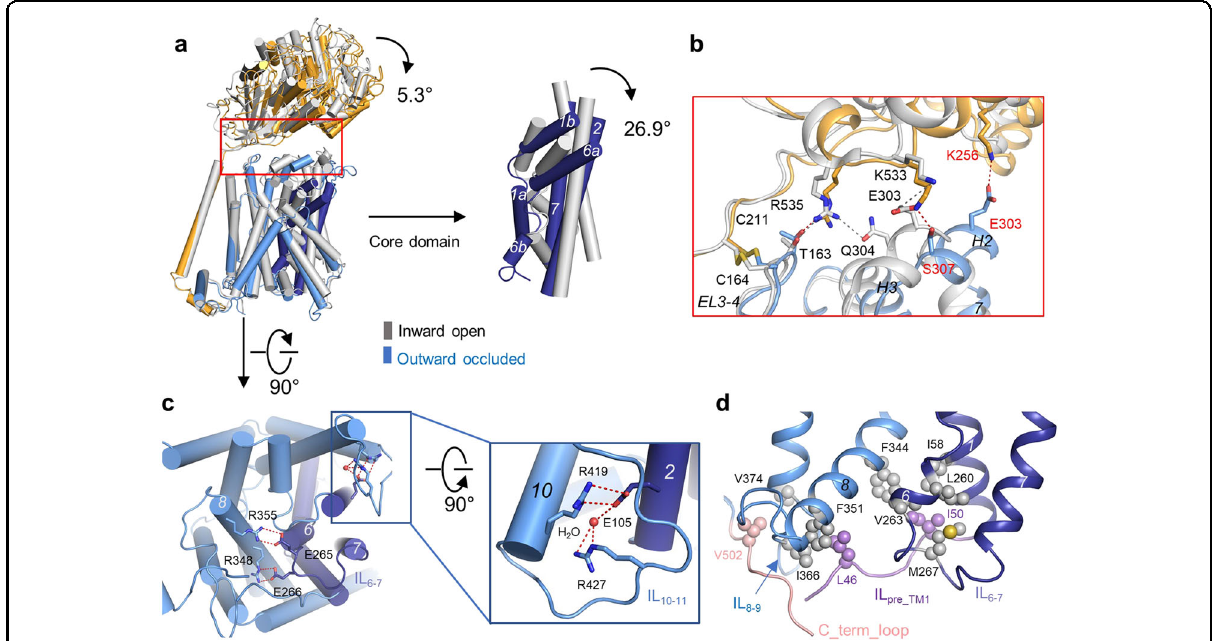
Fig. 4 Conformational change between inward-open and outward-occluded state. a Comparison of the outward-occluded structure of LAT1 and the inward-facing structure of LAT1 (PDB ID: 6IRT). The core domain of the outward-occluded LAT1 rotates for ~27° compared with that of inward-open LAT1. The interaction mode at the extracellular interface of the LAT1-4F2hc complex is different between the inward-facing and the outward-occluded conformations. The red box corresponds to b. b The details of the extracellular interface and the polar interactions are shown as red dashed lines for the outward-occluded conformation and gray dashed lines for the inward-facing conformation. The new residues in the outward-occluded conformation are labeled in red. c The hydrogen bond network at the intracellular side of the outward-facing conformation. d The hydrophobic interactions stabilize the outward-facing conformation with the hydrophobic residues shown as spheres.